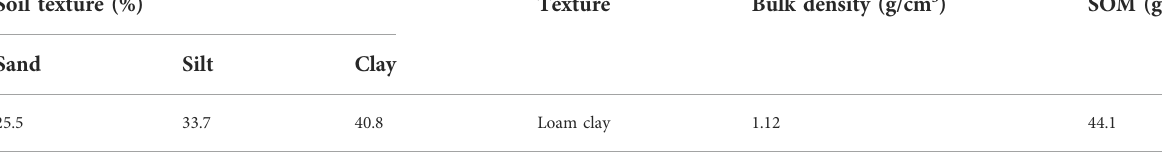
TABLE 1 Basic physical – chemical properties in the study